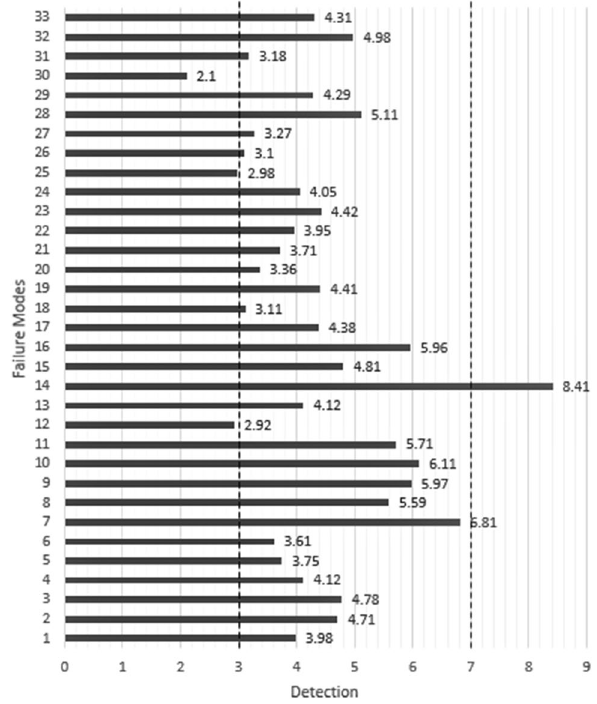
Fig. 5 Comparative chart of "Detection" values